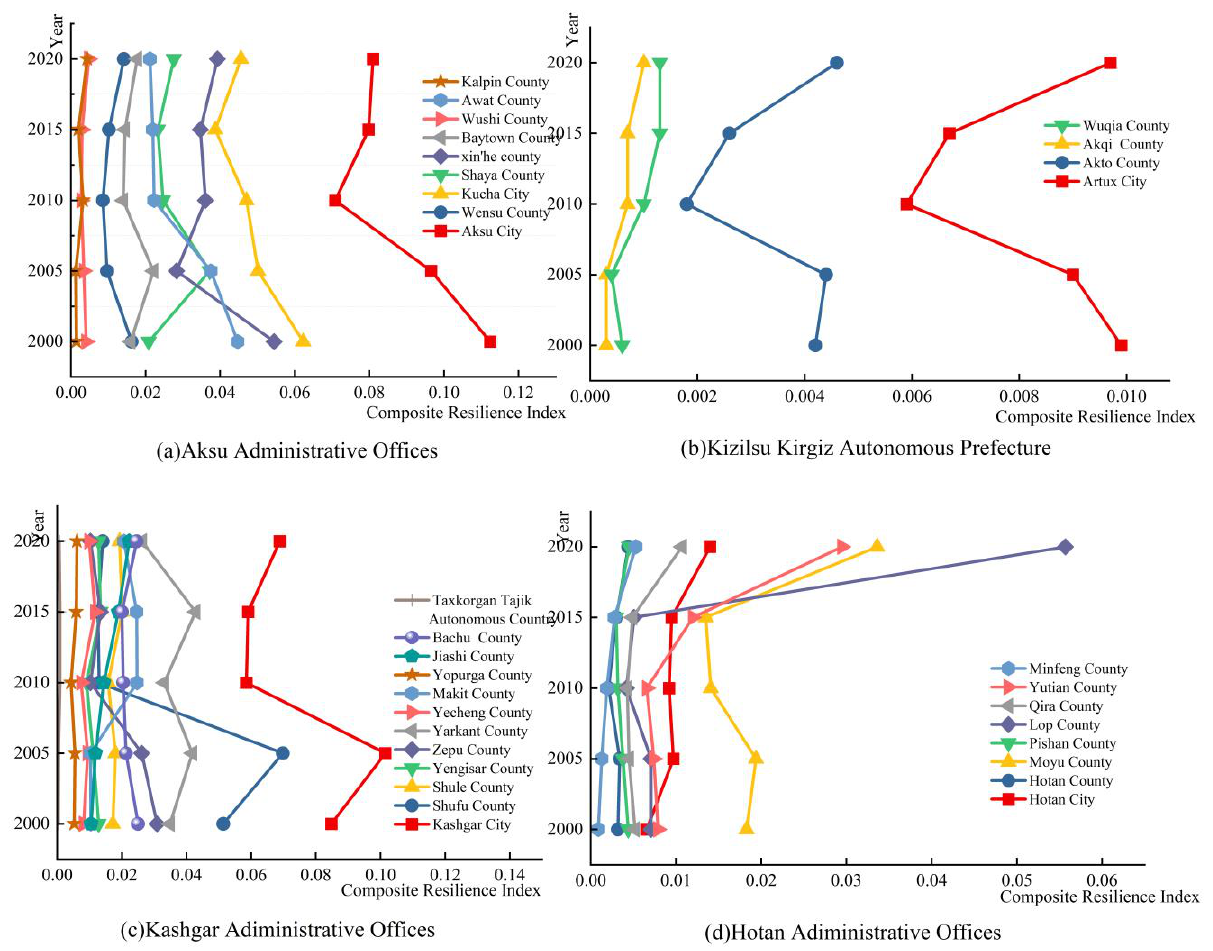
Figure 10. ( a ) Comprehensive resilience index of Aksu Administrative Offices from 2000 to 2020. ( b ) Comprehensive resilience index of Kizilsu Kirgiz Autonomous Prefecture from 2000 to 2020. ( c ) Comprehensive resilience index of Kashgar Administrative Offices from 2000 to 2020. ( d ) Comprehensive resilience index of Hotan Administrative Offices from 2000 to 2020.